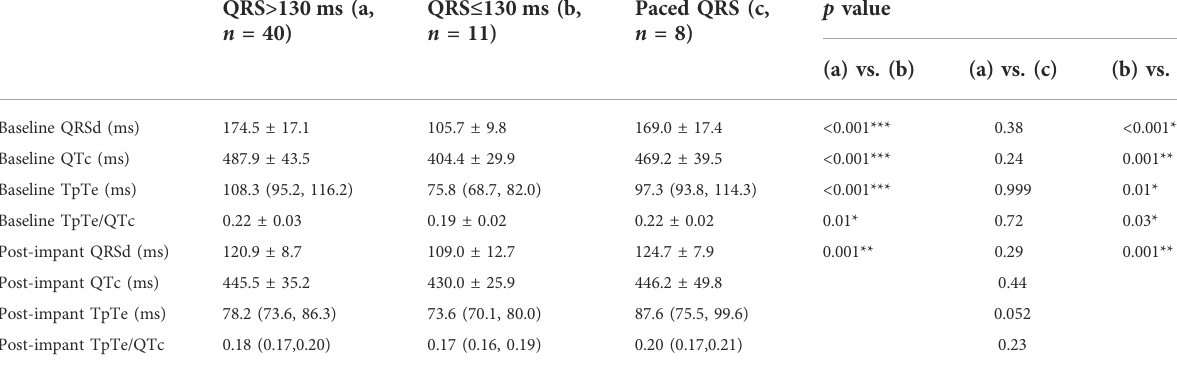
TABLE 3 Comparison of electrocardiographic data between patients with different QRS con fi guration at